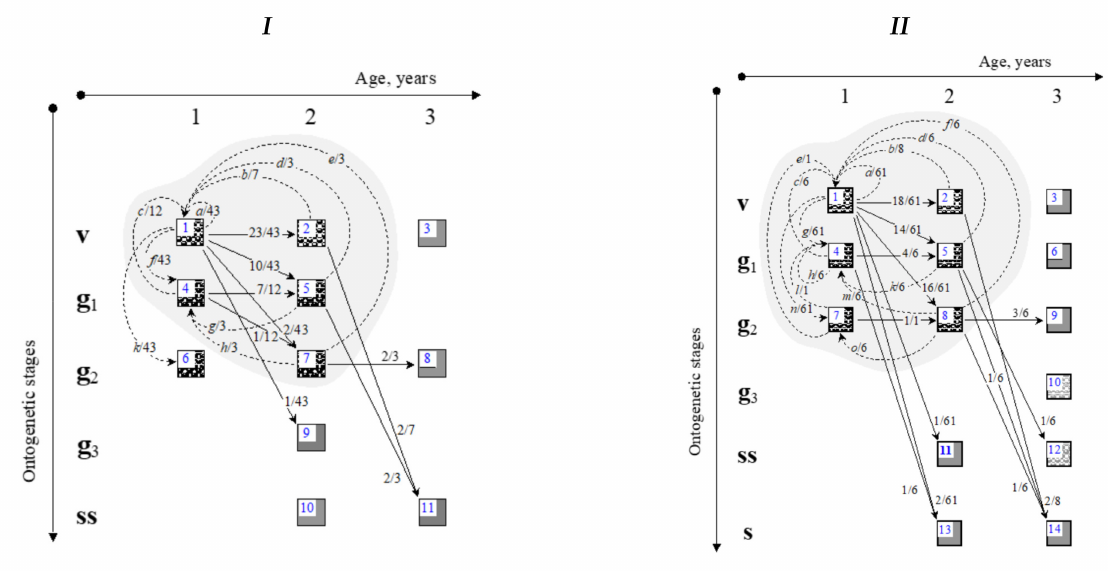
Figure 2. LCGs for Calamagrostis epigeios according to the excavation data of the 3-year-old colonies ( I and II ) in 2015: v denotes the stage of adult vegetative plants; g i (i = 1, 2, 3), generative plans with i generative shoots; ss and s , subsenile and senile stages, respectively. Solid arrows indicate the ontogenetic transitions to have occurred for 1 year: numbers at the arrows indicate proportions of the tufts outgoing from an initial status in 2014 and reaching the ingoing status by 2015; the number inside the vertex is the ordinal number the corresponding component has in the vector of population structure; gray background highlights the reproductive core of the LCG